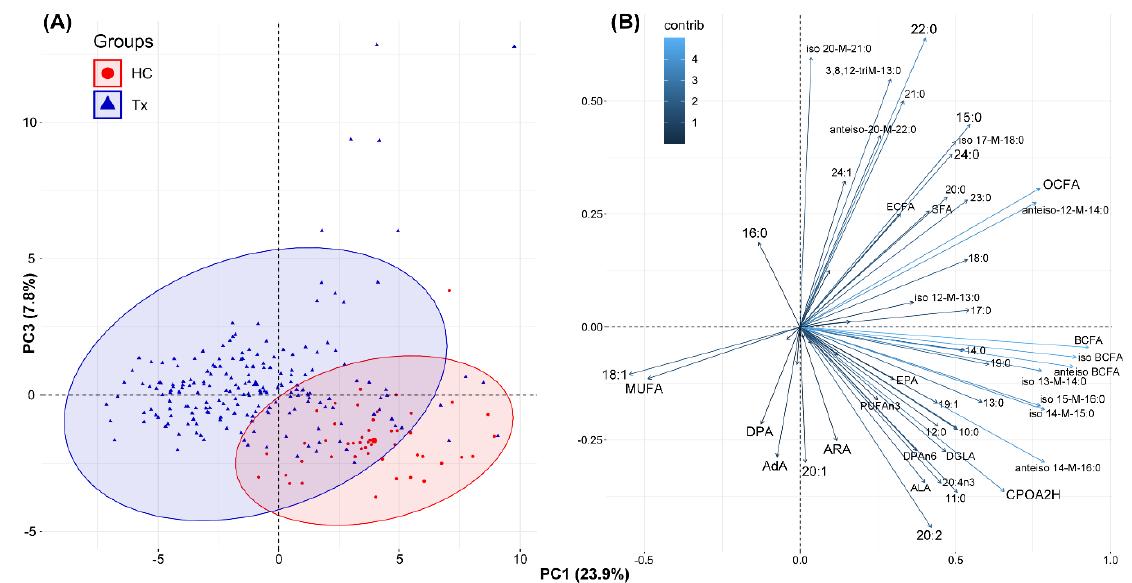
Figure 1. The results of PCA based on the serum fatty acid profiles: score plot of cases ( A ) and variables ( B ) for healthy control (HC) and Tx (transplant) patients. For statistical significance of differences between groups please consult Table 2. AdA-adrenic acid; ALA- α -linolenic acid; ARA-arachidonic acid; BCFA-branched chain fatty acids; CPOA2H-cyclopro- paneoctanoic acid 2-hexyl; DGLA-dihomo- γ -linolenic acid; DHA-docosahexaenoic acid; DPA n3-docosapentaenoic acid n3; DPAn6-docosapentaenoic acid n6; ECFA-even chain fatty acids; EPA-eicosapentaenoic acid; ETA-eicosatetraenoic